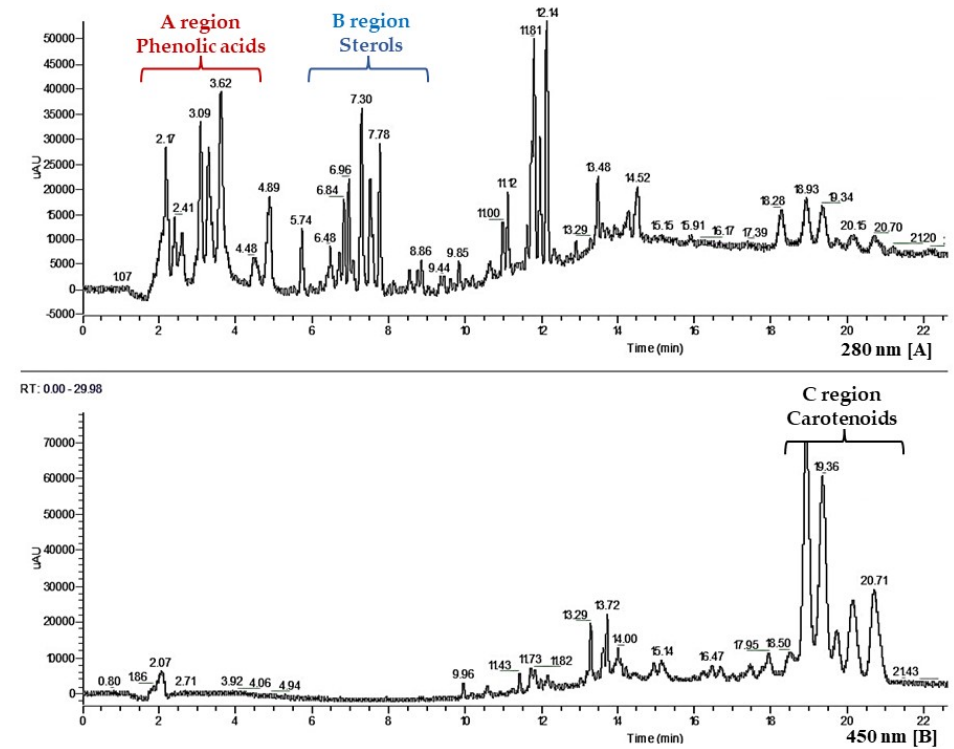
Figure 5. HPLC analysis of fraction 9; Panel A : Phenolics peaks (A region), Sterols peaks (B region); Panel B: carotenoids peaks (C region).